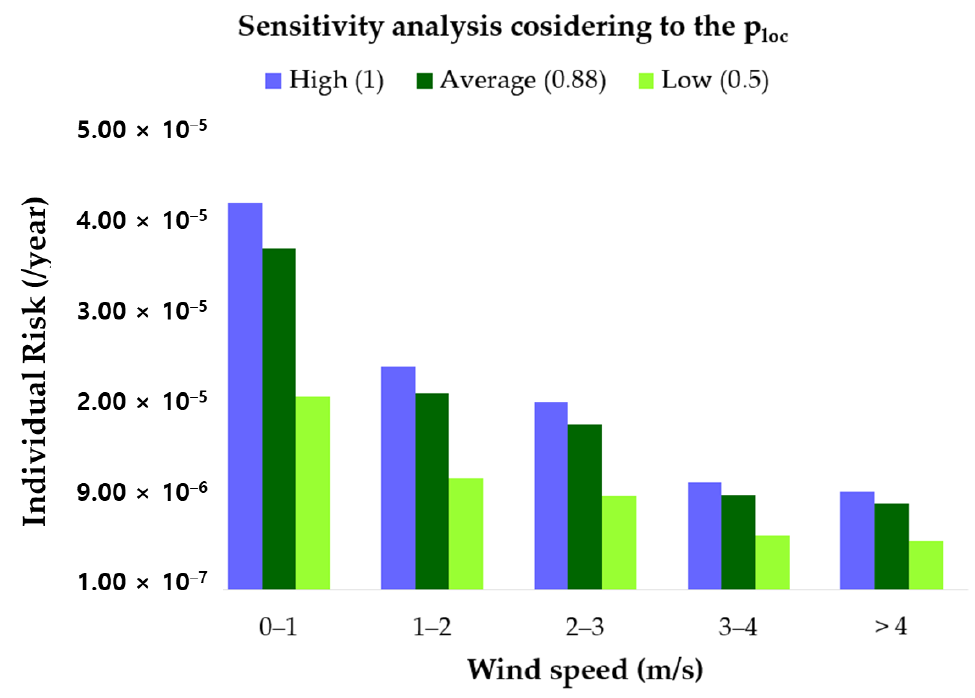
Figure 12. Sensitivity analysis considering to the 𝑝 𝑙𝑜𝑐